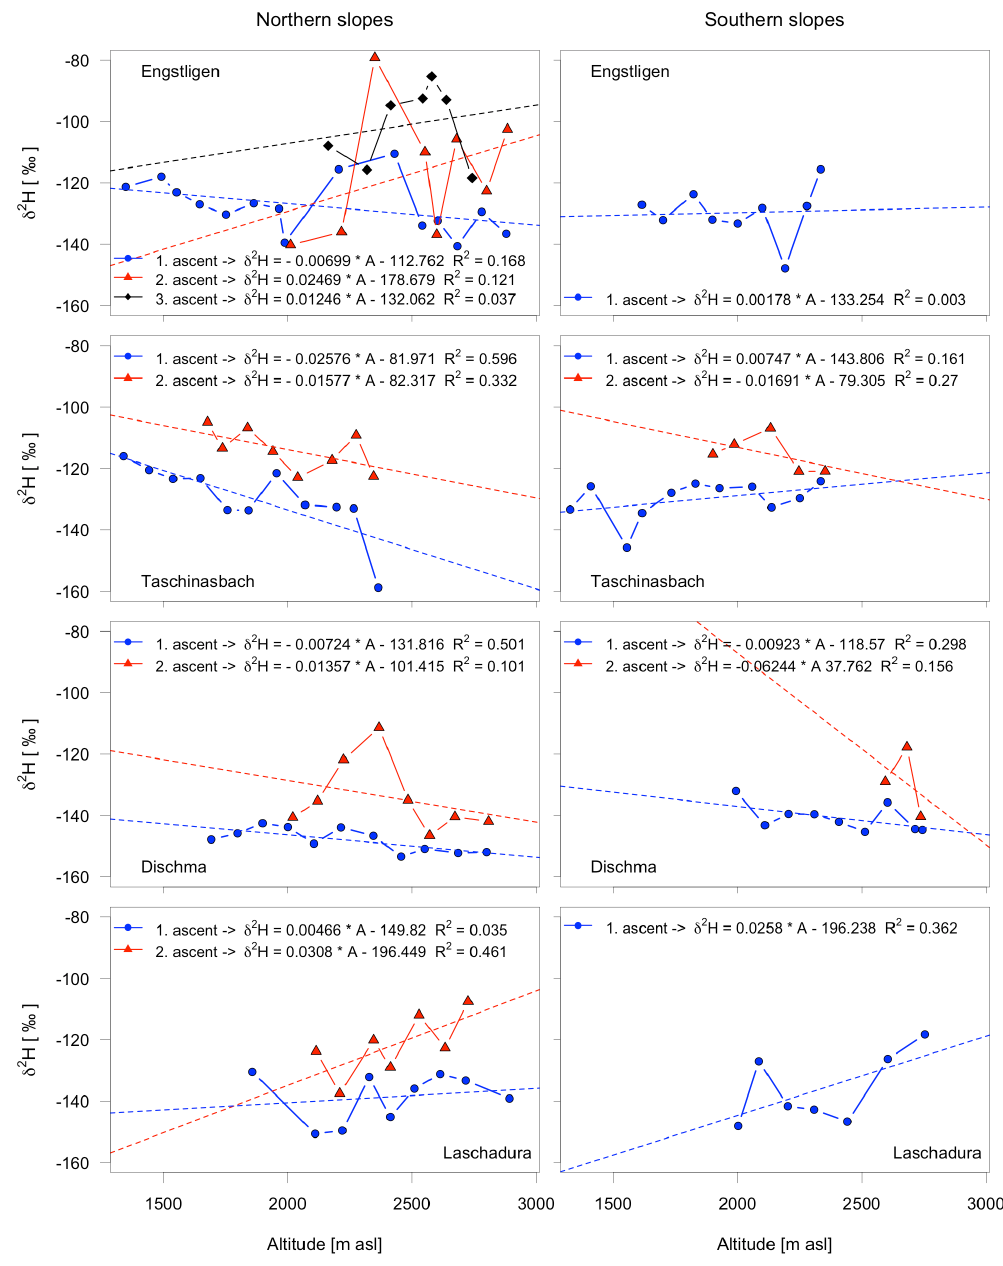
Fig. 4. Mean isotopic content of δ 2 H in snow cover at every sample point and associated altitudinal gradient for every sampling time (ascent).